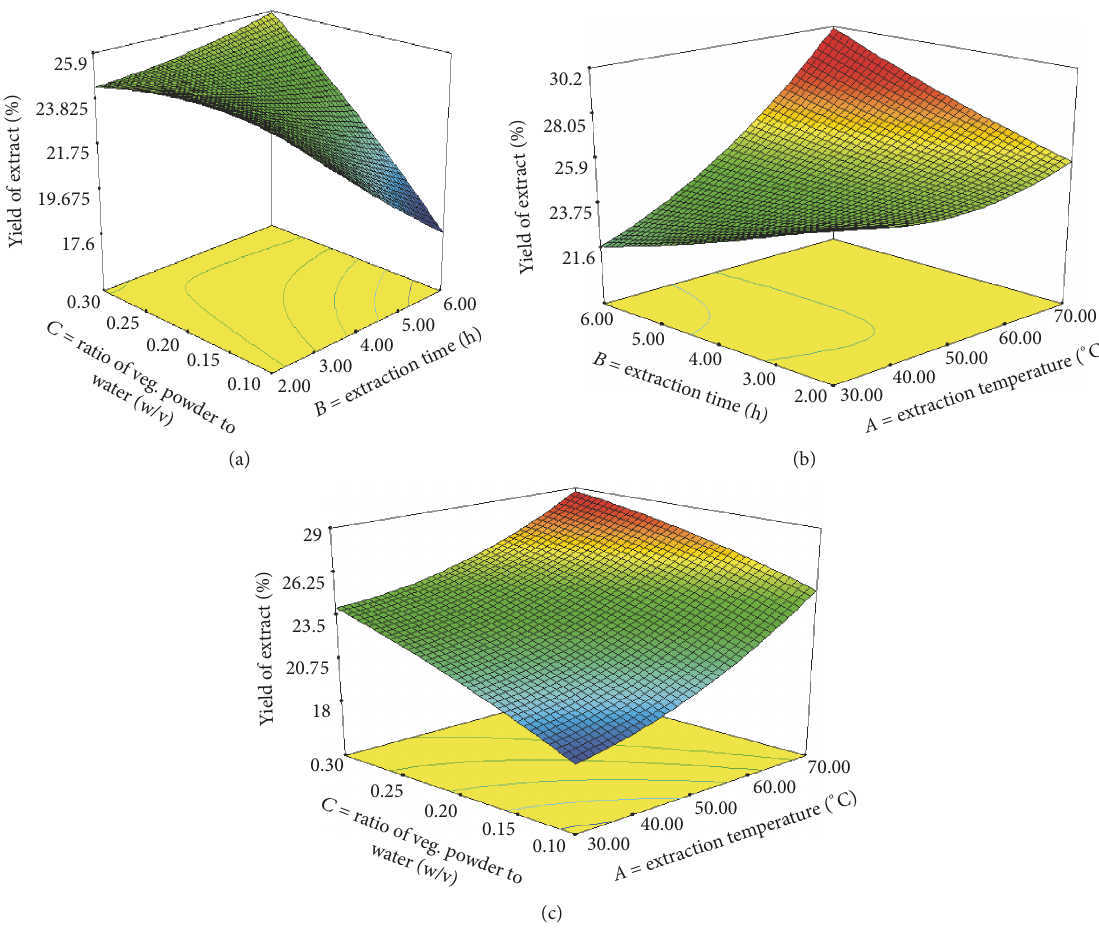
Figure 2: Interaction effects on the yield of Solanum macrocarpon polyphenol concentrates: (a) vegetable powder :water ratio and extraction time; (b) extraction time and temperature; (c) vegetable powder : water ratio and extraction